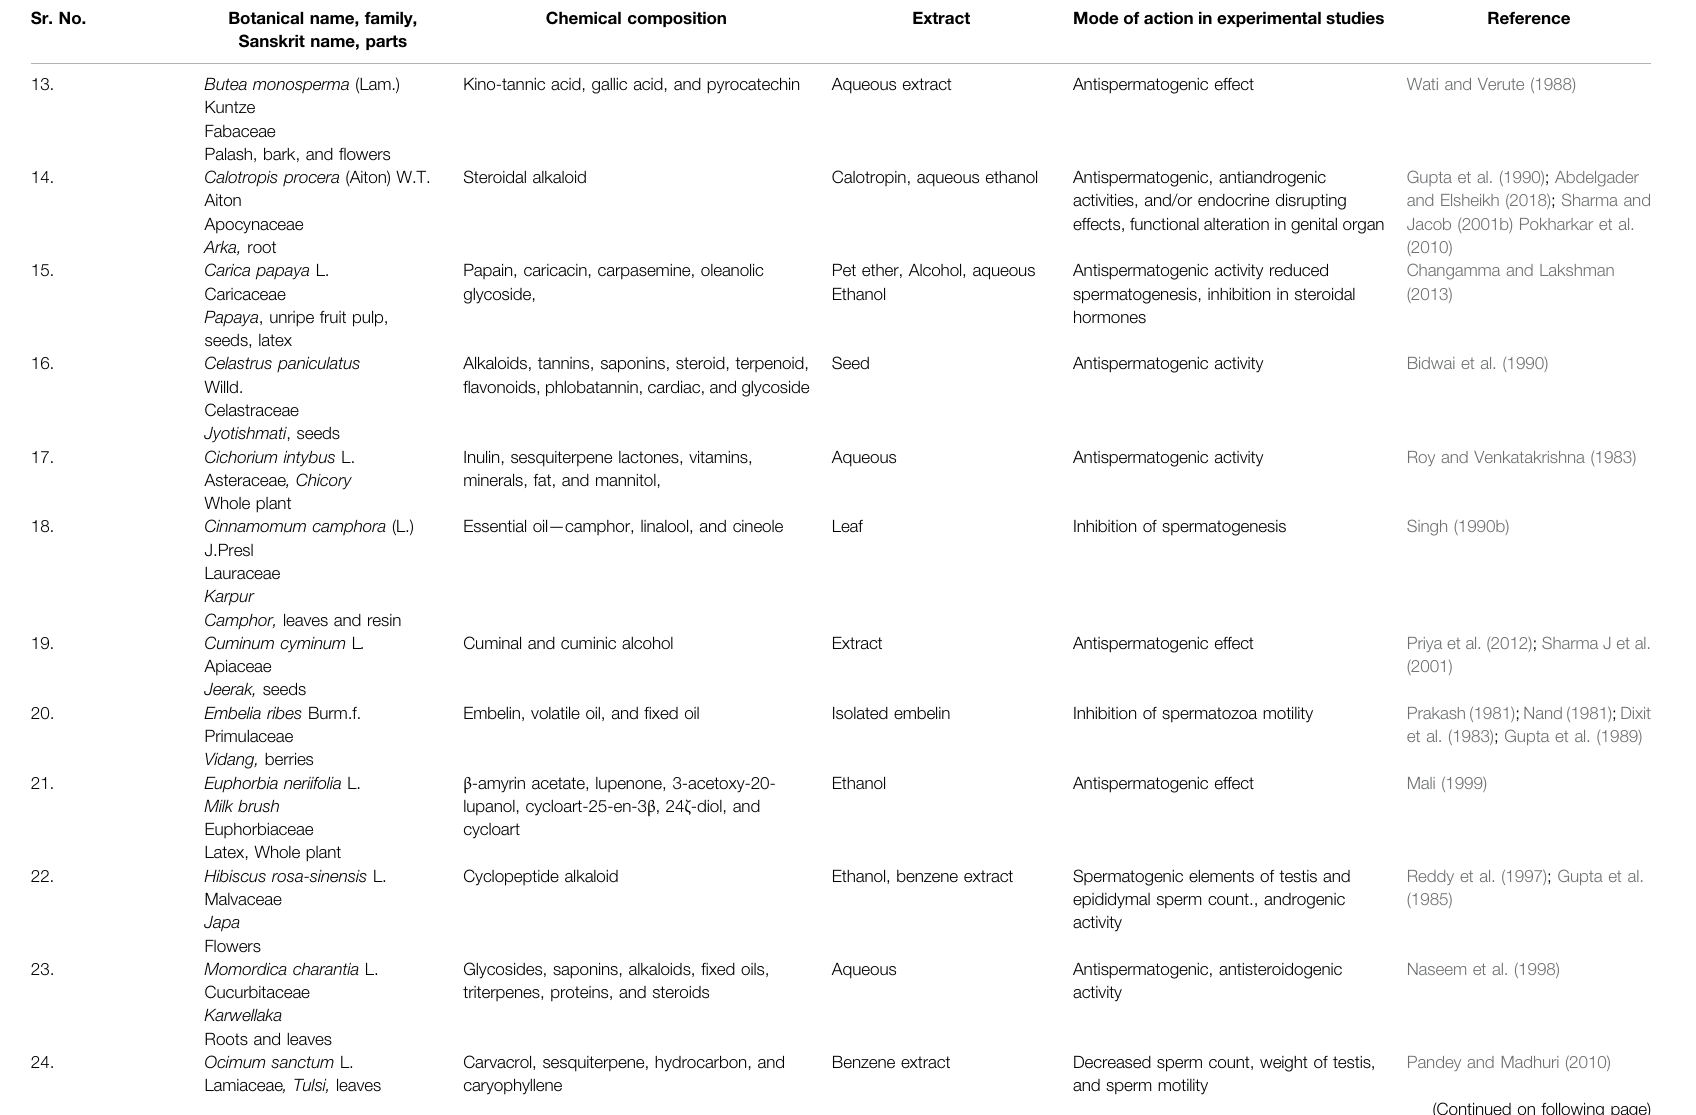
TABLE 2 | ( Continued ) Medicinal plants and their phyotoconstituents validated for various female/male contraceptive activities. Different contraceptive activities studied on medicinal plants could be categorized as follows. Female contraceptive activities: (2A) anti-implantation activity, (2B) aborti fi cation, (2C) antifertility, (2D) antiovulatory, and (2E) antiestrogenic activity. Male contraceptive activities: (2F) antispermatogenic, (2G) spermicidal, and (2H) antiandrogenic